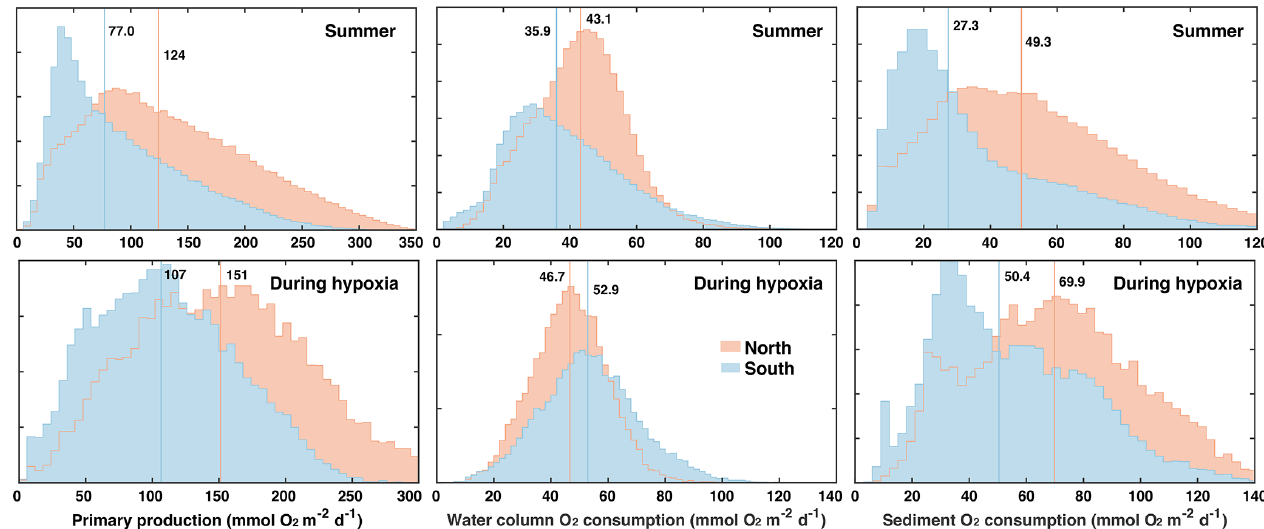
Figure 6. Histograms of primary production and water-column and sediment respiration during the summer months (June to September) and during hypoxic conditions in the northern and southern parts of the typically hypoxic zone. Medians are indicated by vertical lines.